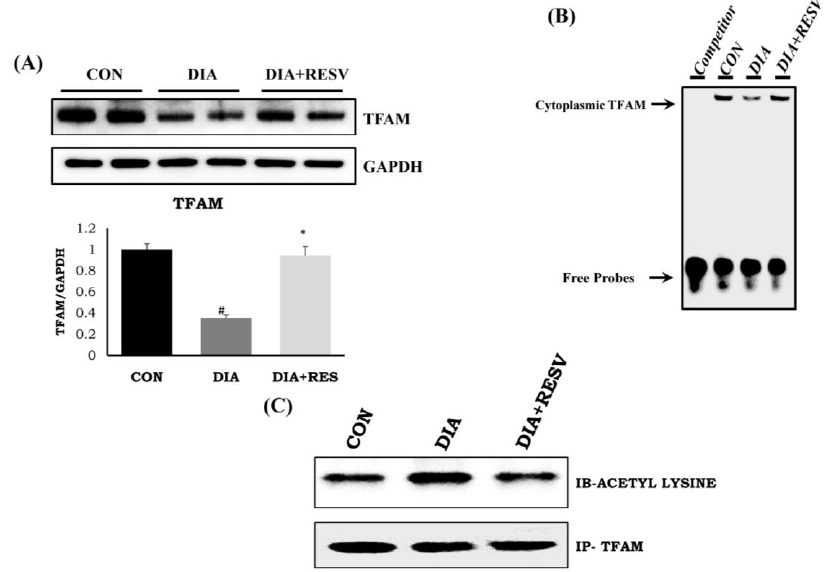
Figure 3. mRNA expression profile of mitochondrial encoded genes in diabetic heart and effect of resveratrol administration . Data shown as mean ± SE, ( n = 5) # p < 0.05 vs. Con; * p < 0.05 vs. DIA group.